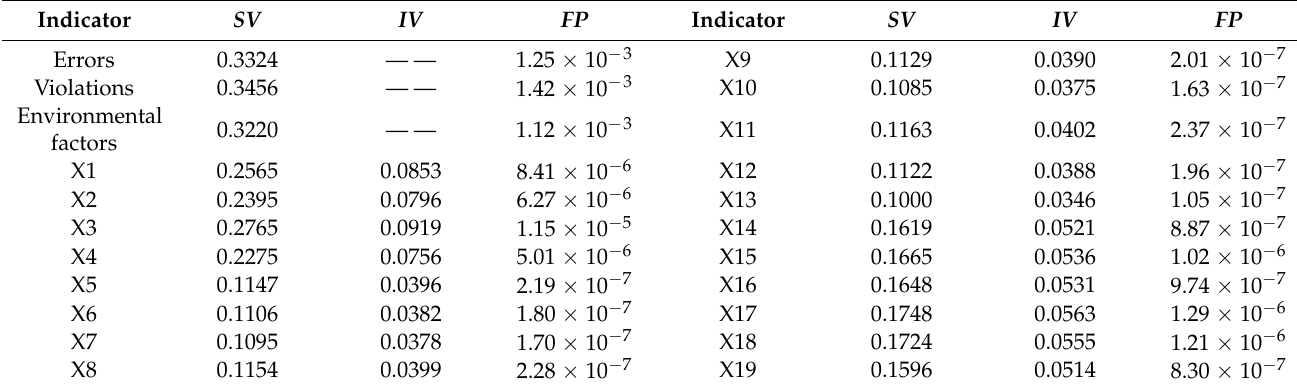
Table 5. Weight assignment of the identified human factors.